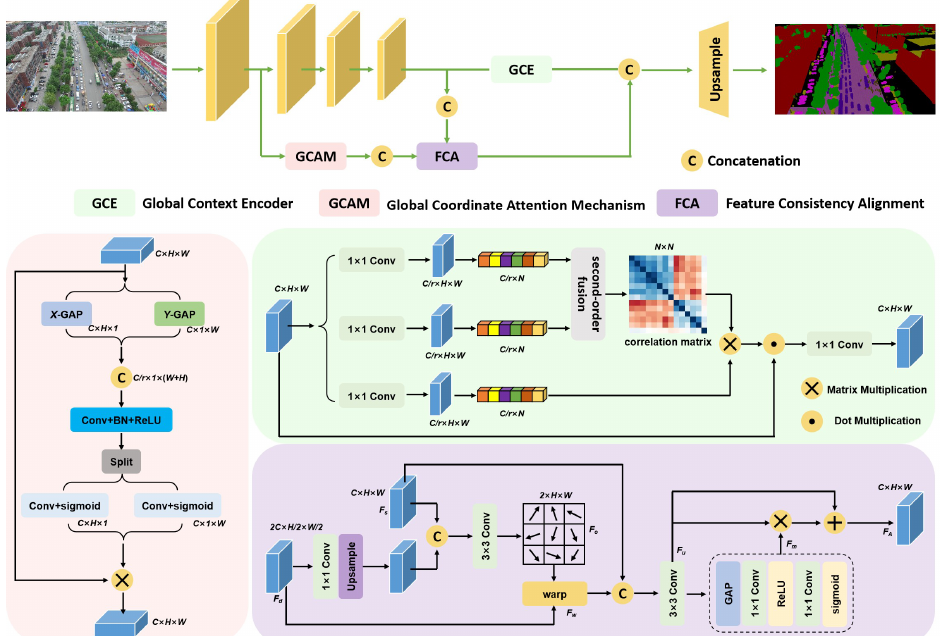
Figure 2. Illustration of the proposed global feature attention network (GFANet). The global context encoder is adopted to build global spatial dependency and suppress adversarial noise. The global coordinate attention mechanism and feature consistency alignment are used for global feature enhancement and fusion of shallow and deep features. Each feature map is shown with the size of its tensor (e.g., h , w , and c represent the height, width, and the number of channels,